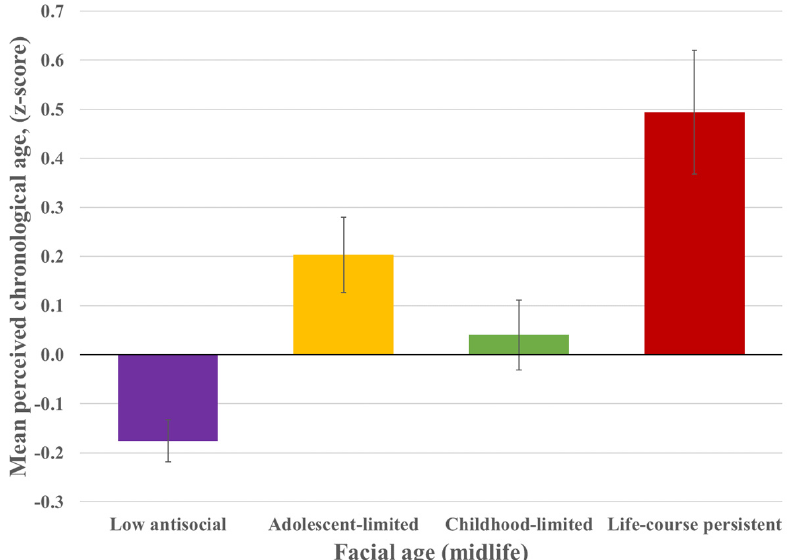
Figure 3. Facial age among individuals following four developmental trajectories of antisocial behavior: Low antisocial (n = 471), Adolescence-limited (n = 173), Childhood-limited (n = 207), and Life-course persistent (n = 83). Panel shows the mean and standard errors of facial age in standardized units.